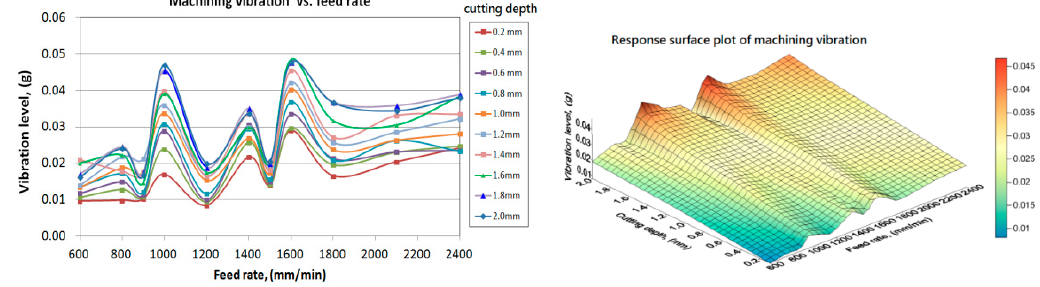
Figure 10. Variation of vibration level under different feed rates and specific cutting depths.